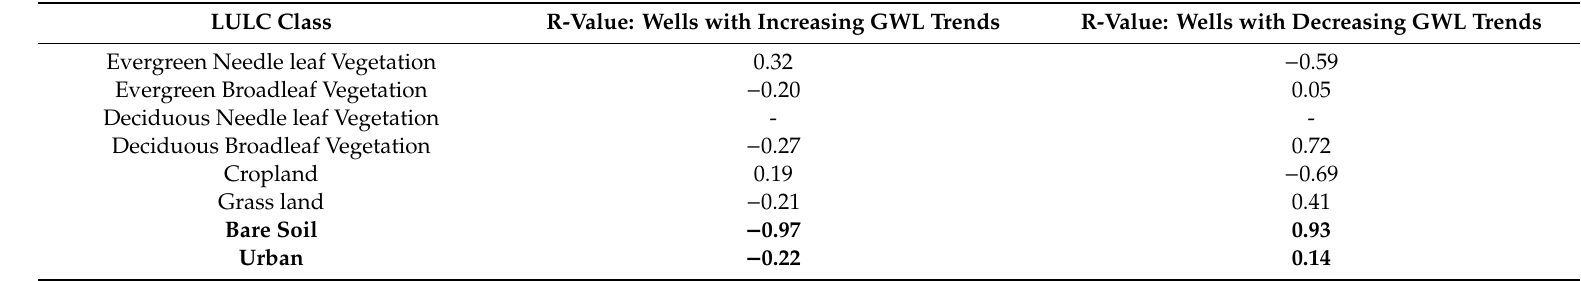
Table 4. Correlation coe ffi cient (R) values for change in the area of di ff erent LULC classes with the groundwater level in the selected cities. LULC